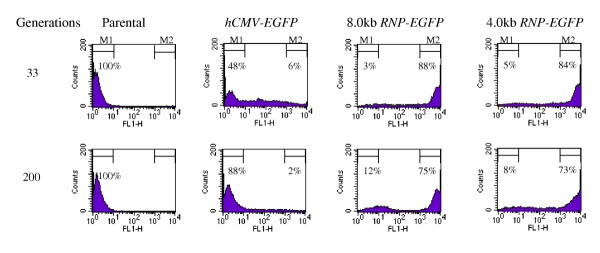
FACScan analysis of EGFP expressing CHO-K1 cells. Following stable transfection with hCMV-EGFP, 8.0 kb RNP-EGFP, or 4.0 kb RNP-EGFP, pools of >100 transfectants were cultured continuously with drug selection for 200 generations, and FACScan analysis conducted after 33 and 200 generations. The results are plotted as green fluorescence on a logarithmic scale (FL1-H) versus number of events on a linear scale (counts). Figures for gate M1 are % cells with undetectable fluorescence; those for gate M2 are % cells showing greater than 1000 fluorescence units.